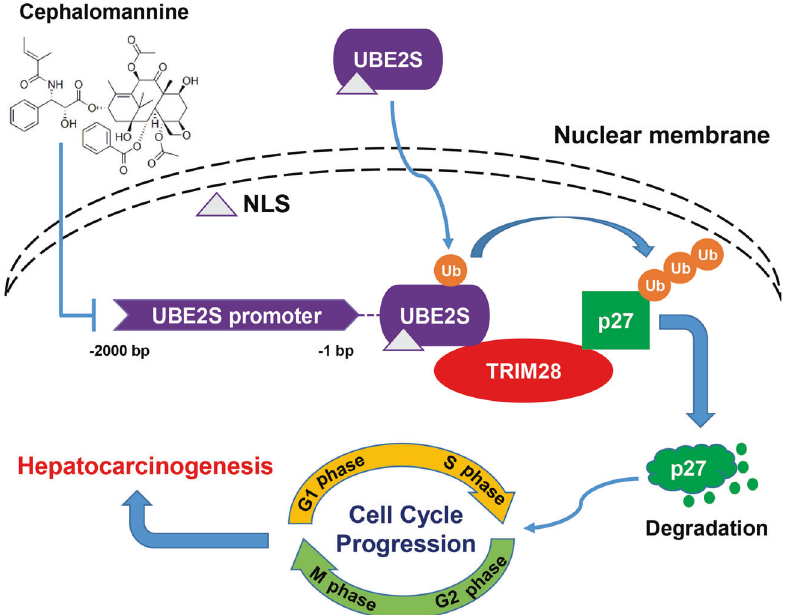
Fig. 6 Schematic of the molecular